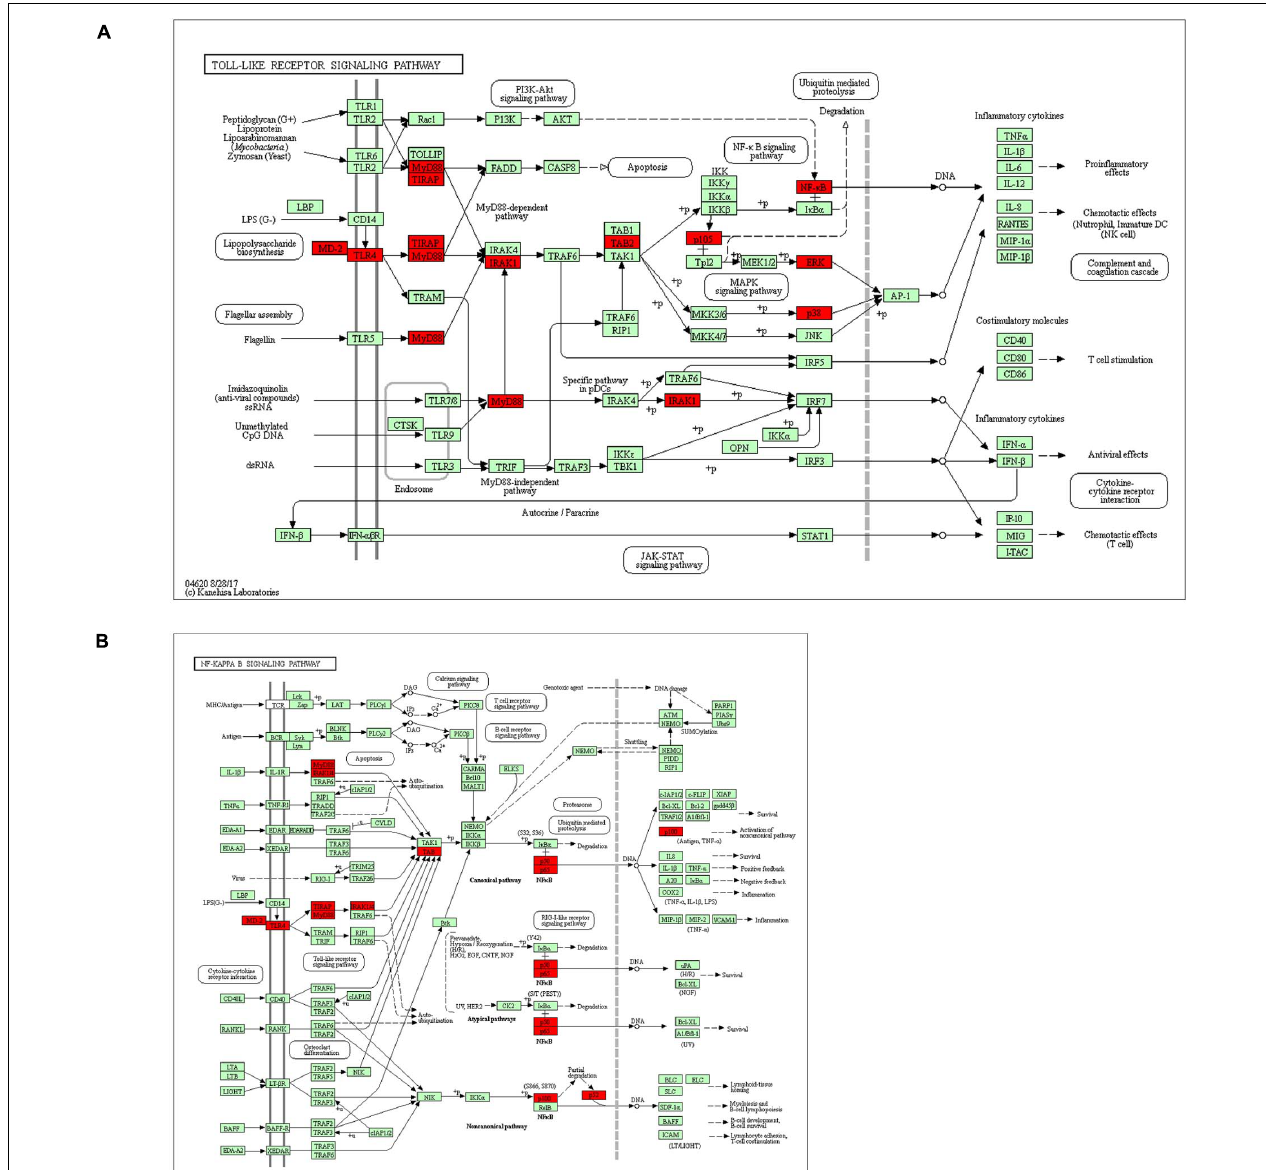
FIGURE 8 | Toll-like receptor signaling pathway and NF-kappa B signaling pathway regulated by the S100s alteration in